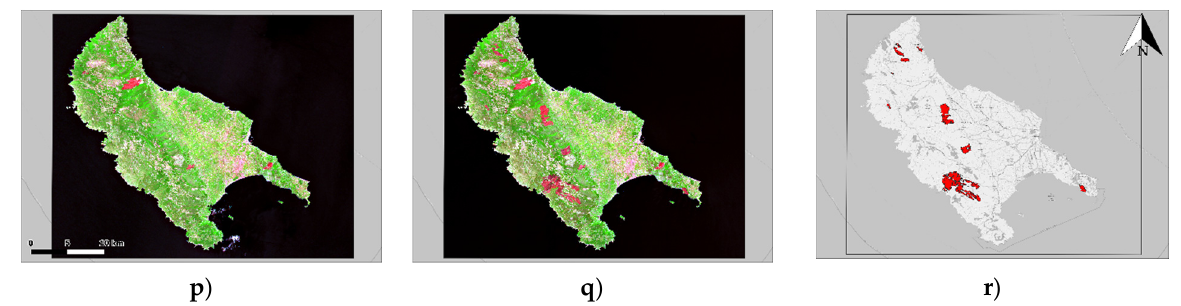
Figure 2. Pre- and post-fire S2 images (first and second column) and EMS fire grading maps (last column) for each site: Vesuvius, Italy, ( a – c ); Leiria, Portugal, ( d – f ); Calar, Spain ( g – i ); Huelva, Spain ( j – l ); Kalamos, Greece ( m – o ); Zakynthos, Greece ( p – r ). S2 images are displayed as RGB false color composites (SWIR2, NIR, red). Notice that for Kalamos and Zakynthos sites, Greece, no fire damage grading maps are available from EMS.